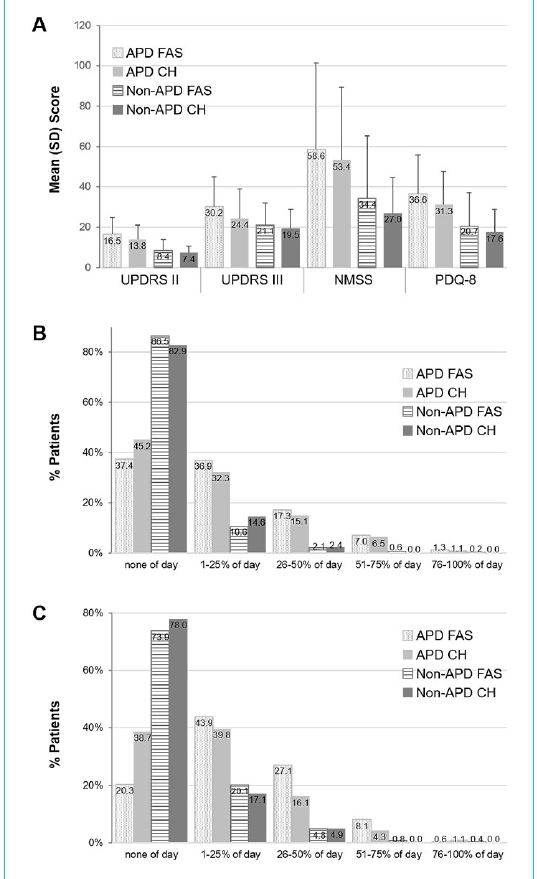
Figure 2: Comparison of the international (FAS) data with the Swiss subgroup. A) Activities of daily living (UPDRS II), motor symptom severity (UPDRS III), non-motor symptom burden (NMSS) and quality of life (PDQ-8); B) Dyskinesia duration (UP- DRS Part IV Q32, categories); C) Average duration of “off” time (UPDRS Part IV Q39, categories). Error bars indicate standard